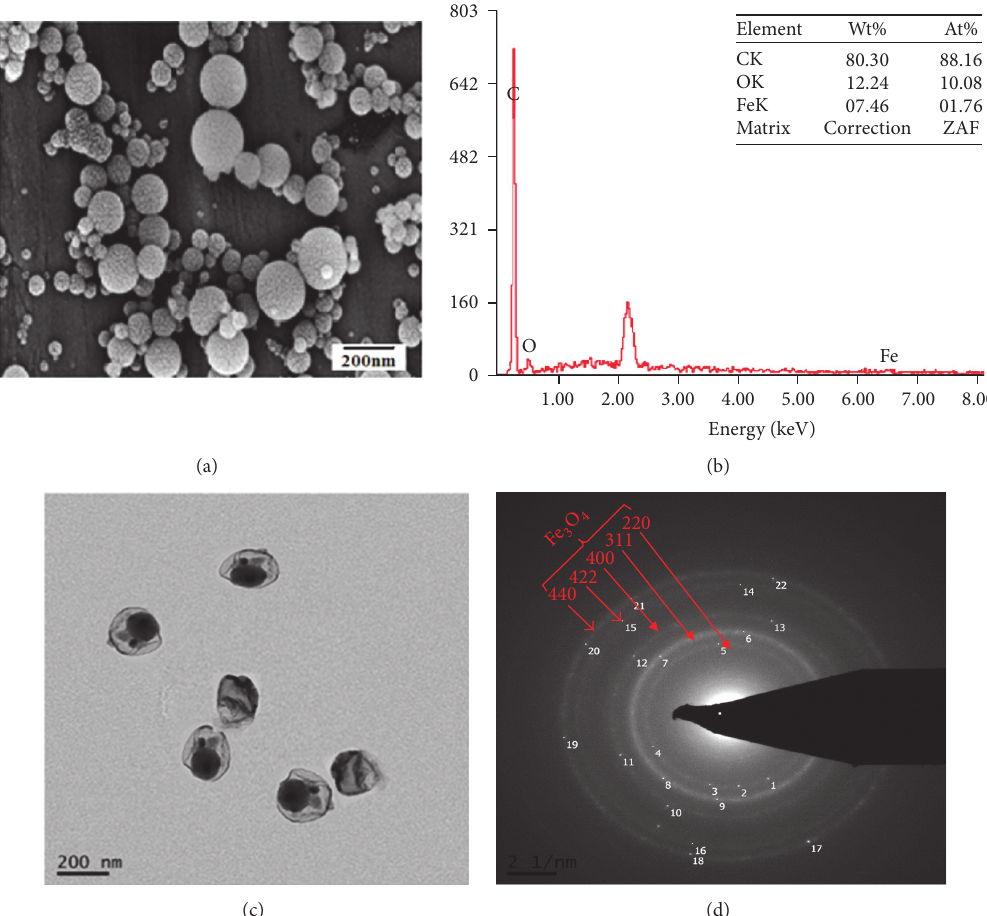
Figure 3: SEM image (a) and EDS spectrum (b) of Fe(OH) 3 @PMMA microspheres; TEM image (c) and single sphere SAED pattern (d) of magnetic microspheres.